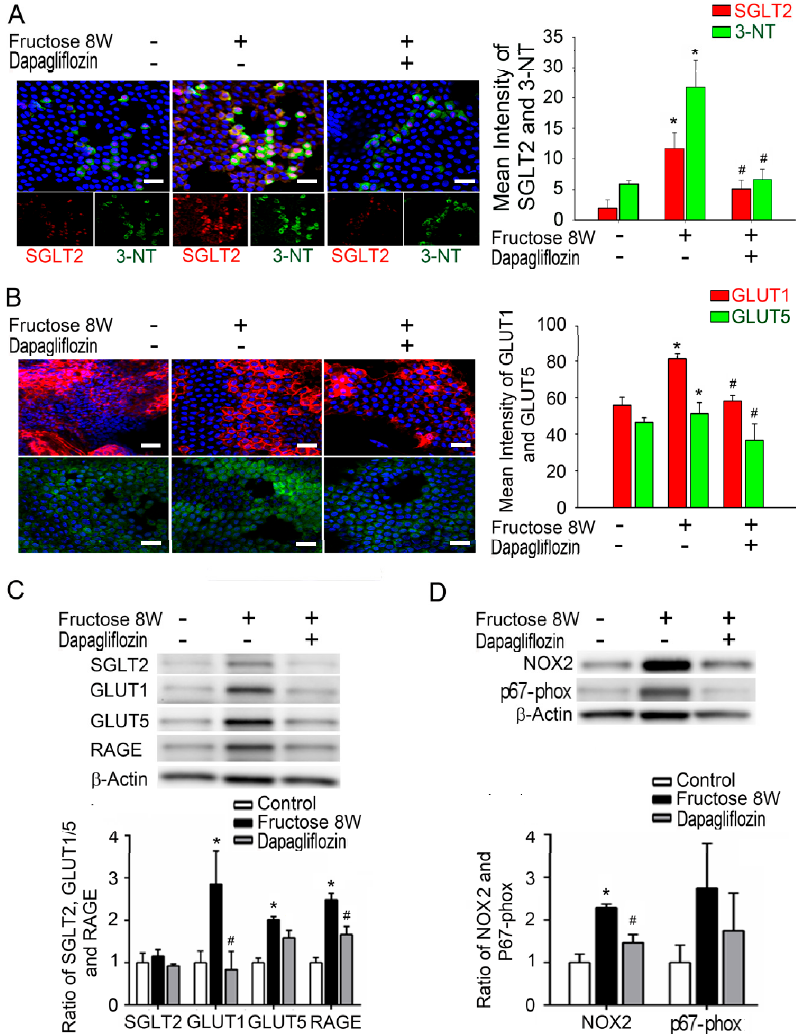
Figure 4. Dapagliflozin blocked the sodium-glucose cotransporter 2 (SGLT2)-induced production of the NADPH Oxidase Subunits and the receptor for advanced glycation end products (RAGE) in lens epithelial sections of type 2 diabetes mellitus (DM) rats. ( A – B ) Representative fluorescence images of 3-nitrotyrosine- (3-NT) and glucose transporter (GLUT)5-expressing cells (green) and SGLT2- and GLUT1-expressing cells (red) in the lens of rats with or without the systemic administration of fructose or dapagliflozin. Cell nuclei are counterstained with DAPI (blue). The presented values are the means ± SEMs ( n = 6 per group, separate experimental groups in each figure). ( C – D ) Quantitative immunoblotting analysis demonstrating that the expression levels of SGLT2, GLUT1, GLUT5, RAGE, NOX2 and p67-phox in the lenses of rats with fructose-induced type 2 DM were decreased by dapagliflozin administration. Scale bar: 20 µ m. The presented values are the means ± SEMs ( n = 6 per group, separate experimental groups in each figure). * p < 0.05 vs. control; # p < 0.05 vs. Fructose 8 W.